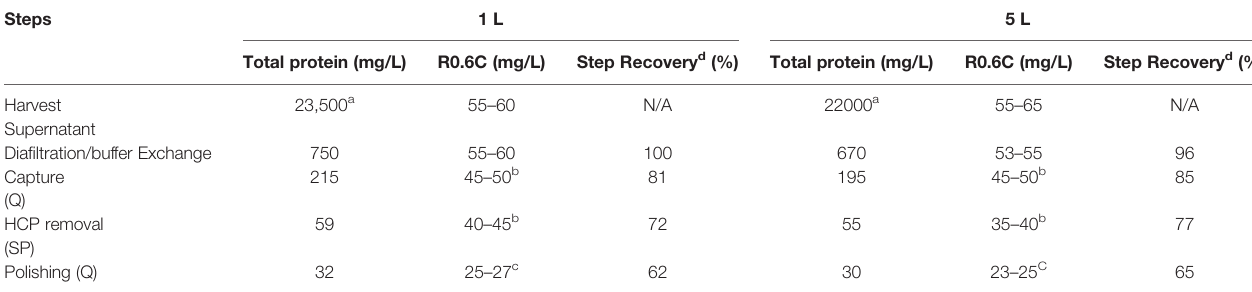
TABLE 2 | Mass Balance summary of